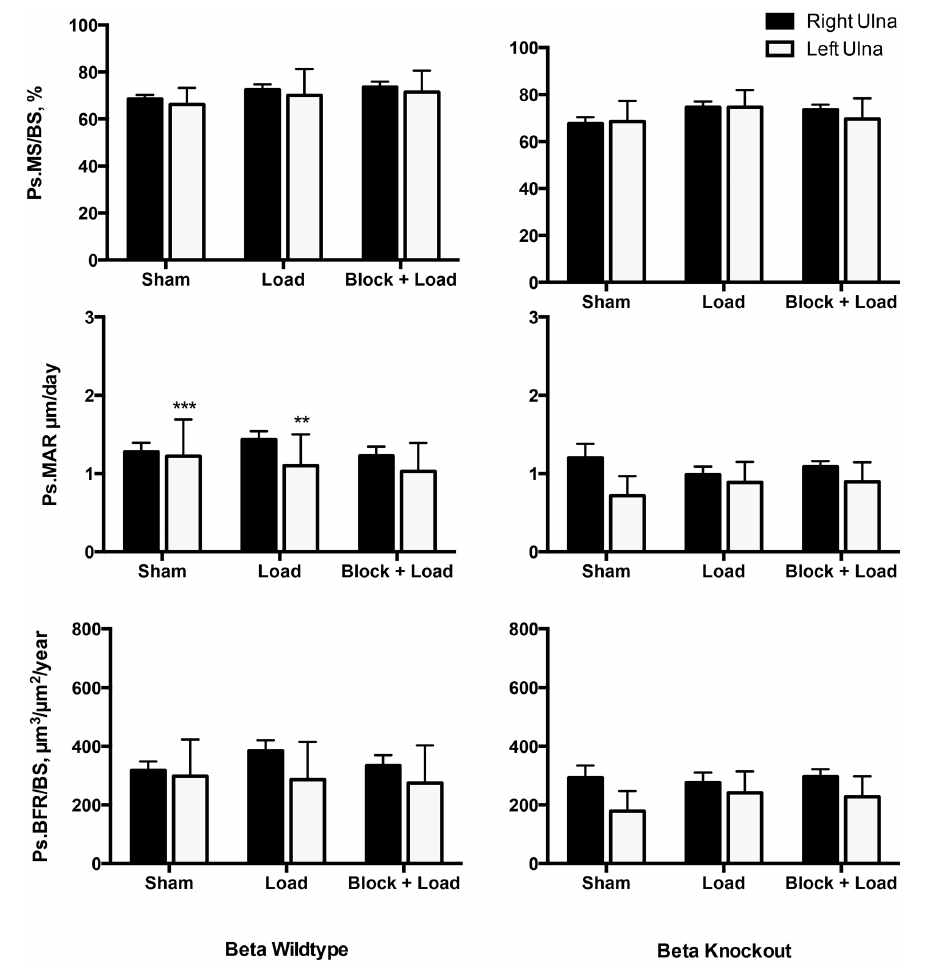
Fig. 5. Load-induced periosteal bone formation responses are similar in CGRP b wildtype and knockout mice. Overall, periosteal mineral apposition rate (Ps.MAR) in CGRP b wildtype and knockout mice was significantly increased in the right ulna, when compared with the left ulna ( p , 0.005). Few other significant treatment effects were identified. ** p , 0.01; *** p , 0.001 versus left ulna in associated CGRP b knockout mice. Sham – sham loaded group, Load – loaded group, Block + Load – Brachial plexus anesthesia treatment before loading. n 5 16–20